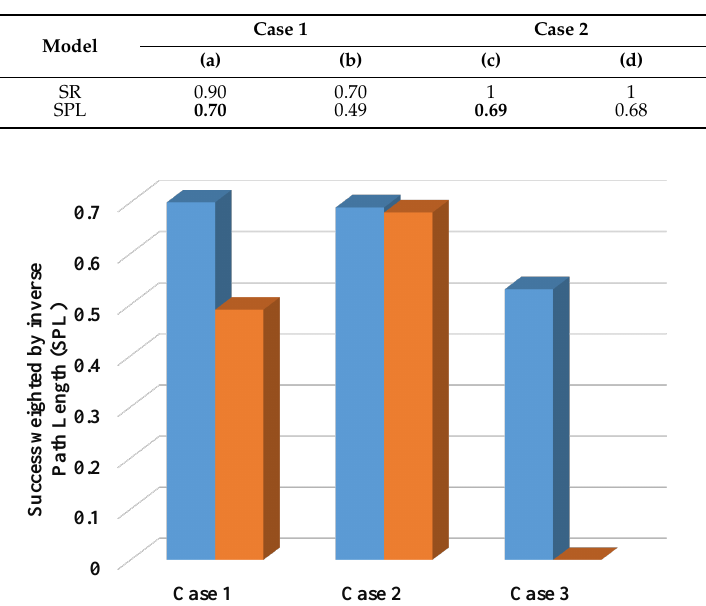
Table 3. The SR and SPL of navigation in all scenarios.